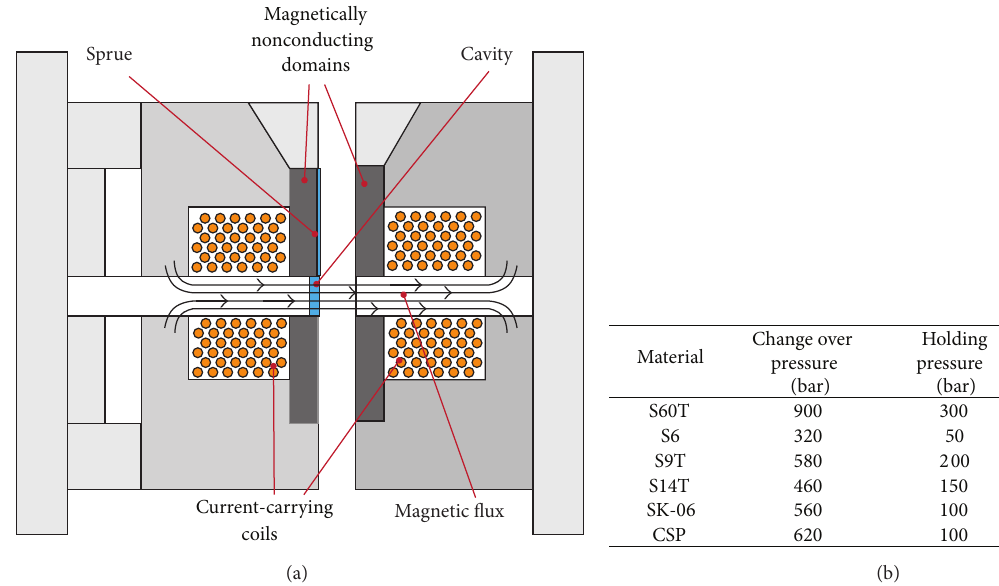
Figure 2: (a) Mold (including illustration of magnetic field), (b) process parameters